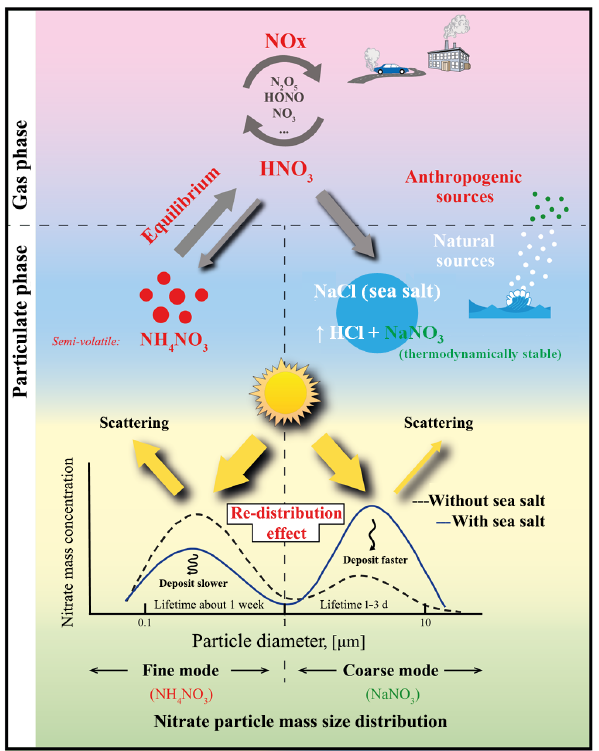
Figure 1. Concept of the redistribution effect induced by sea-salt